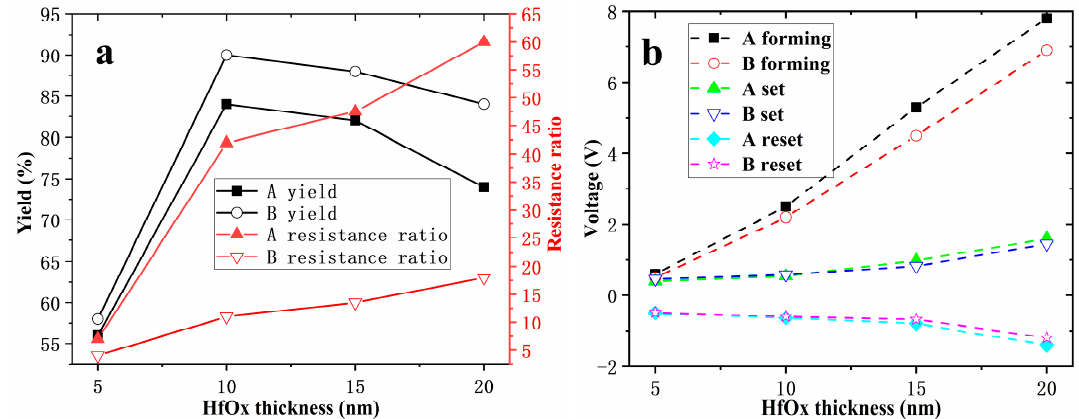
Figure 2. HfO x thickness dependence of yield, resistance ratio ( a ) and operating voltages ( b ).